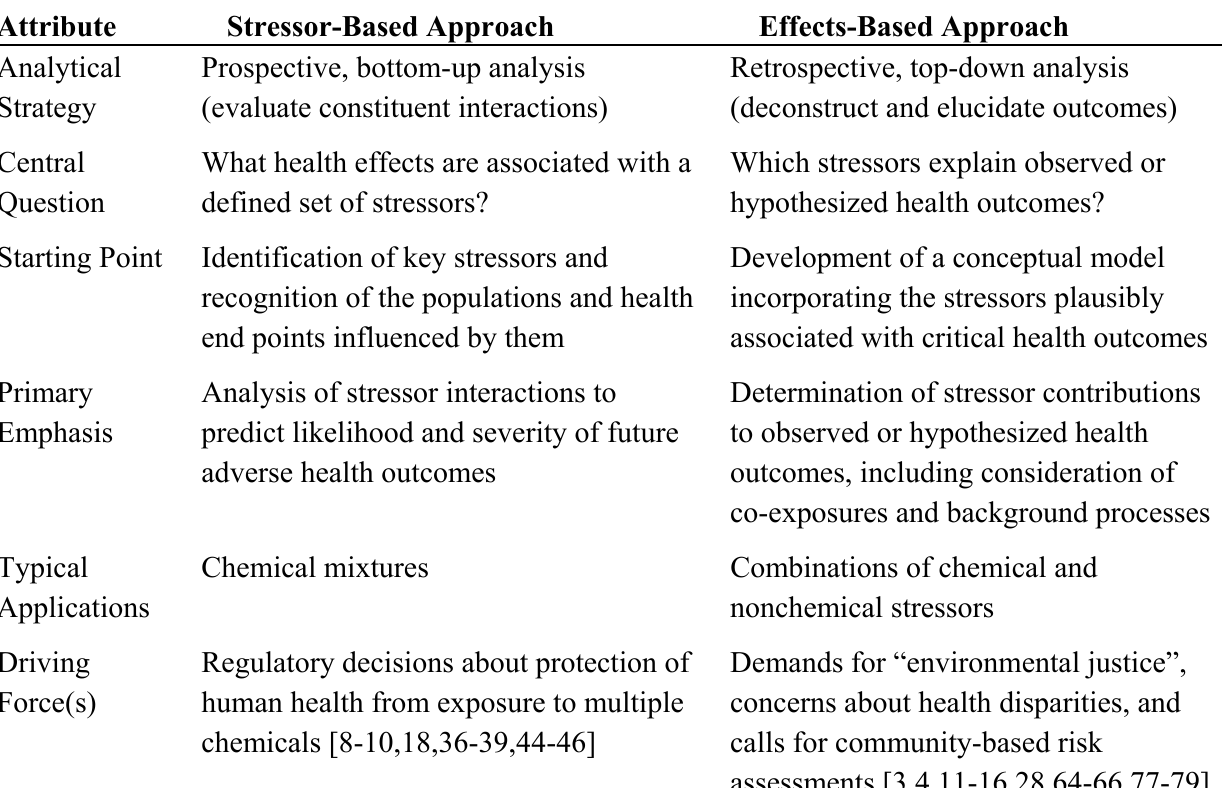
Table 4. Important Differences between Stressor-Based (Bottom-up) and Effects-Based (Top-Down) Approaches to Cumulative Risk